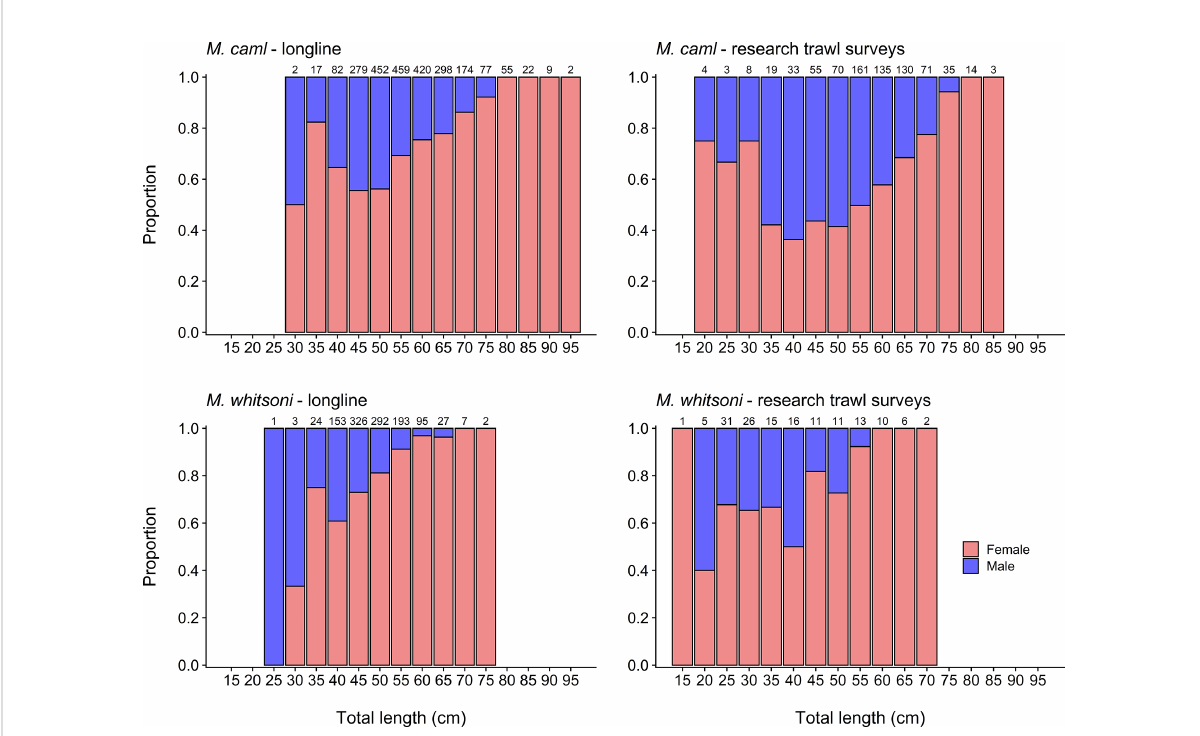
FIGURE 5 Proportion of female and male Macrourus caml (top row) and M. whitsoni (bottom row) by 5 cm total length (TL) class sampled from the Ross Sea region by longline (i.e., the commercial fi shery and the 2016 and 2019 winter surveys) (left column) and fi sheries-independent research trawl surveys in 2015 and 2019 (right column). Sample sizes of each length class are indicated above each bar.